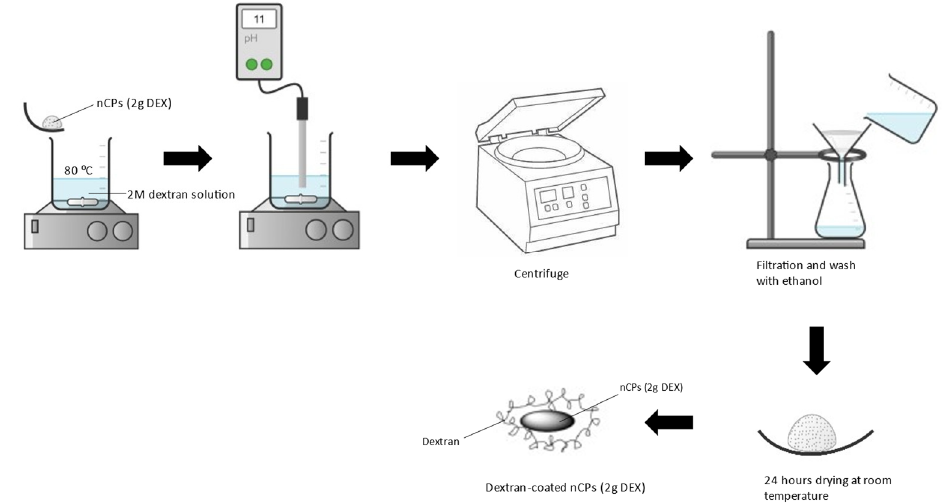
Figure 2. Schematic diagram on synthesis of nCPs coated with dextran.